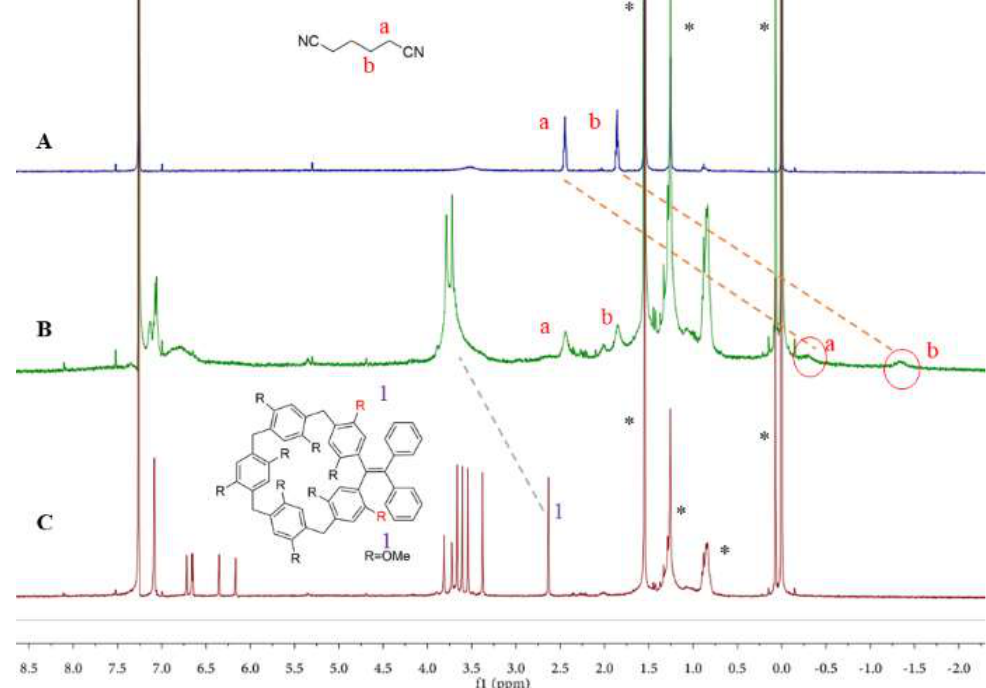
Figure 3. ( A ) 1 H NMR spectra of DCB (1 mM), ( B ) Partial 1 H NMR spectra of the mixed solution of DMP[5]-TPE (1 mM) and DCB (1 mM), ( C ) 1 H NMR spectra of DMP[5]-TPE (1 mM). * = solvent.